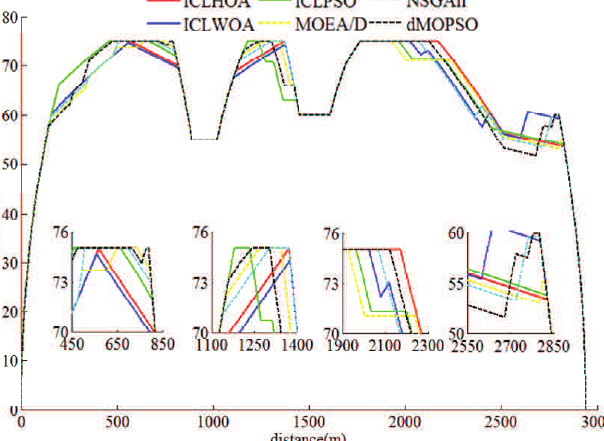
Figure 19. The velocity ideal trajectory profile obtained by different algorithms in Matlab/simulink.